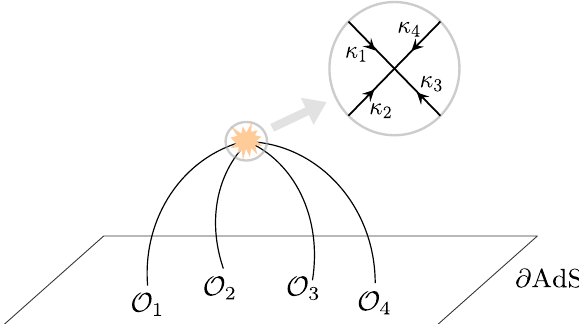
Figure 7. Vertex momenta and their conservation. The saddle-point equation for the contact diagram can be interpreted as the momentum conservation of ‘vertex momenta’ (denoted by κ j ’s), which are momenta of particles measured at a point where all particles meet. Since the particles follow curved trajectories, these momenta in general do not coincide with the boundary momenta introduced in section